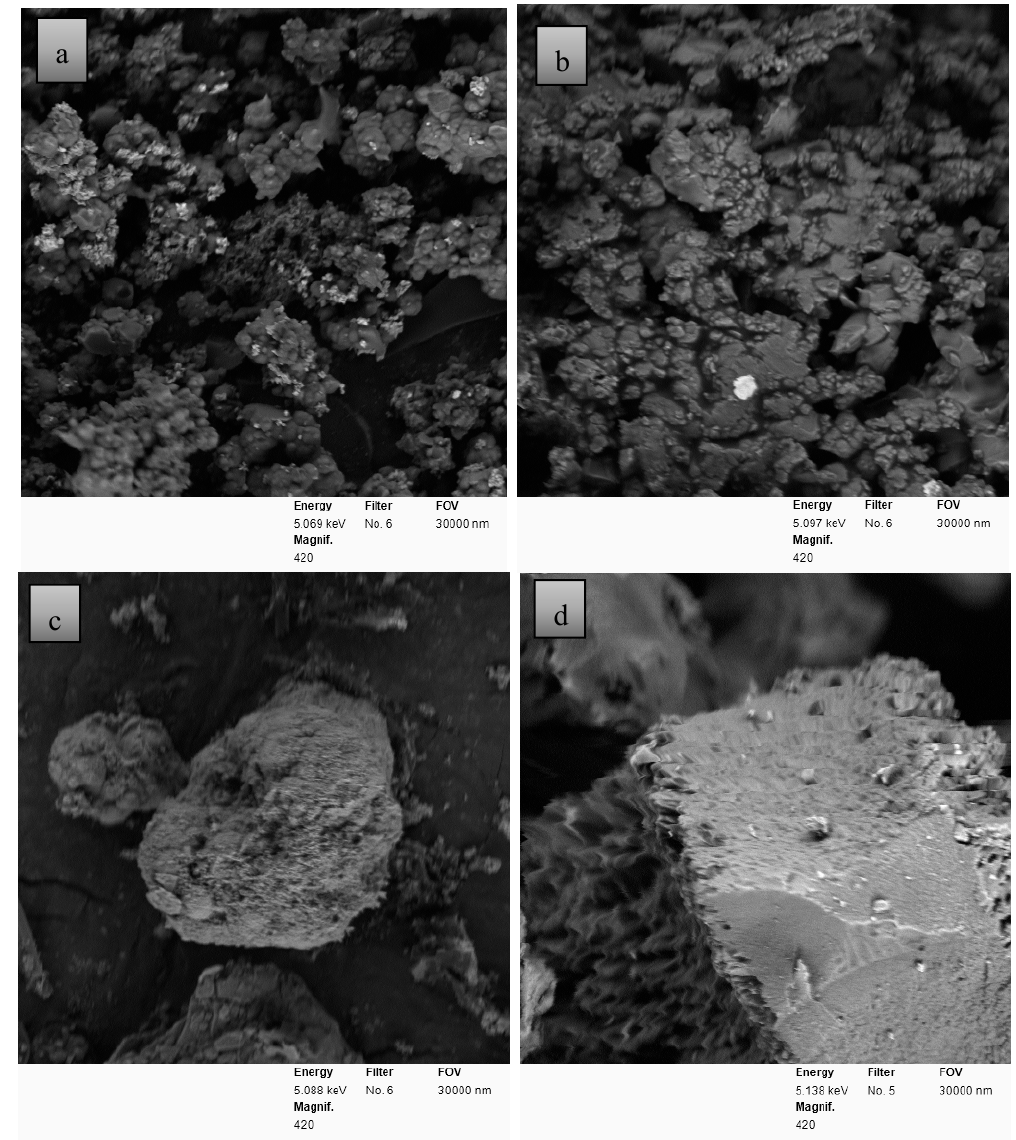
Figure 1. Scanning electron microscope (SEM) images ( a ) first-generation D2, ( b ) second-generation D5, ( c ) third-generation D8, ( d ) fourth-generation D11.